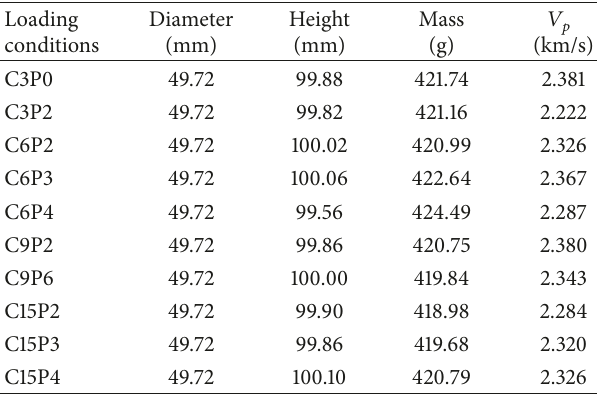
Table 2: Loading conditions and parameters of sandstones with